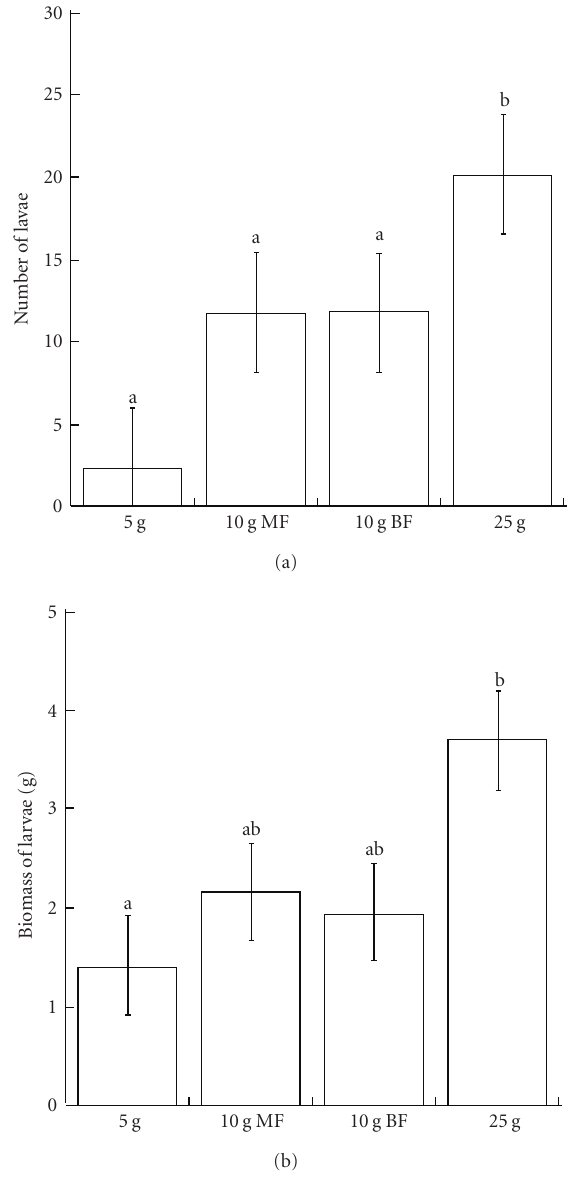
Figure 3: The number (a) and biomass (b) of larvae dispersed from the carcasses in relation to the carcass size and feeding mode. Bars show SE. Di ff erent letters indicate a significant di ff erence (Steel- Dwass test: P < . 05). MF: Maternal feeding, BF: Biparental